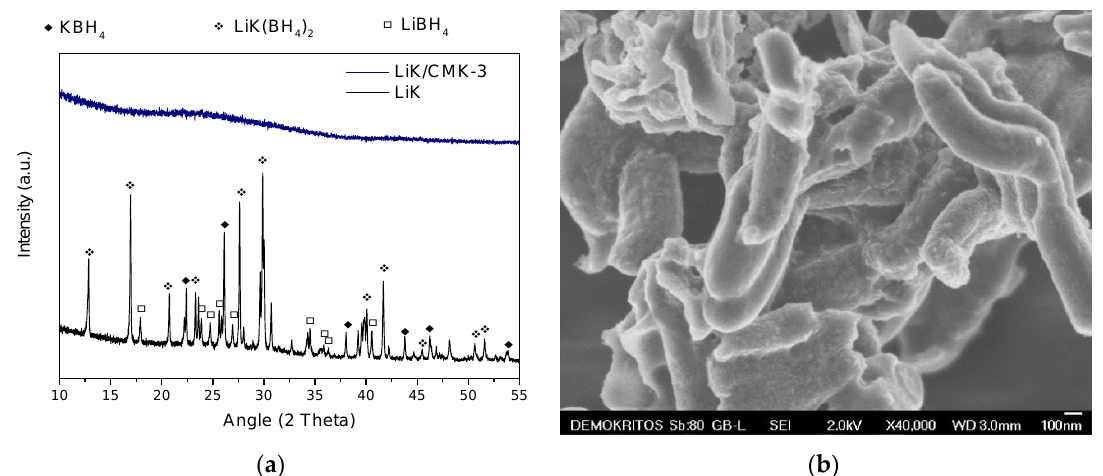
Figure 1. ( a ) PXRD pattern of the bulk LiK mixture (black line) and LiK/CMK-3 composite (blue line). Highlighted peaks relative to: KBH 4 ( ◆ ), LiK(BH 4 ) 2 ( ❖ ) and LiBH 4 (□). ( b ) Scanning electron microscope (SEM) picture of LiK/CMK-3 composite.